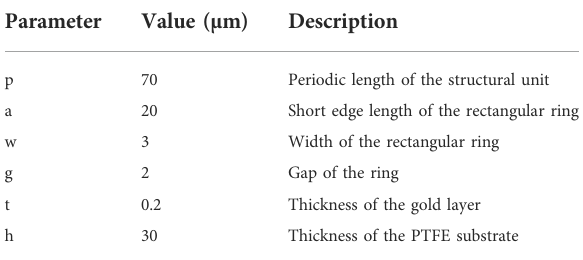
TABLE 1 Geometrical dimensions of the CRSRR